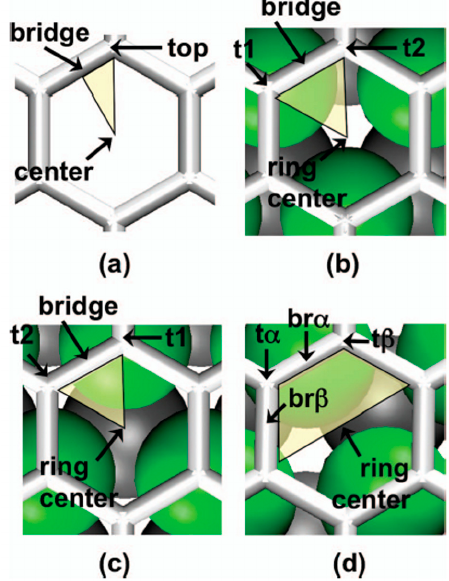
Figure 4. Structures of the (3 × 3) surfaces used for the simulations: ( a ) freestanding graphene; ( b ) graphene on fcc Ru(0001); ( c ) graphene on hcp Ru(0001); and ( d ) graphene on ridge Ru(0001). Graphene is shown as bonds only. Top and second layer Ru atoms are shown as green and grey spheres, respectively. Reproduced from Reference [99] with permission from the American Institute of Physics.